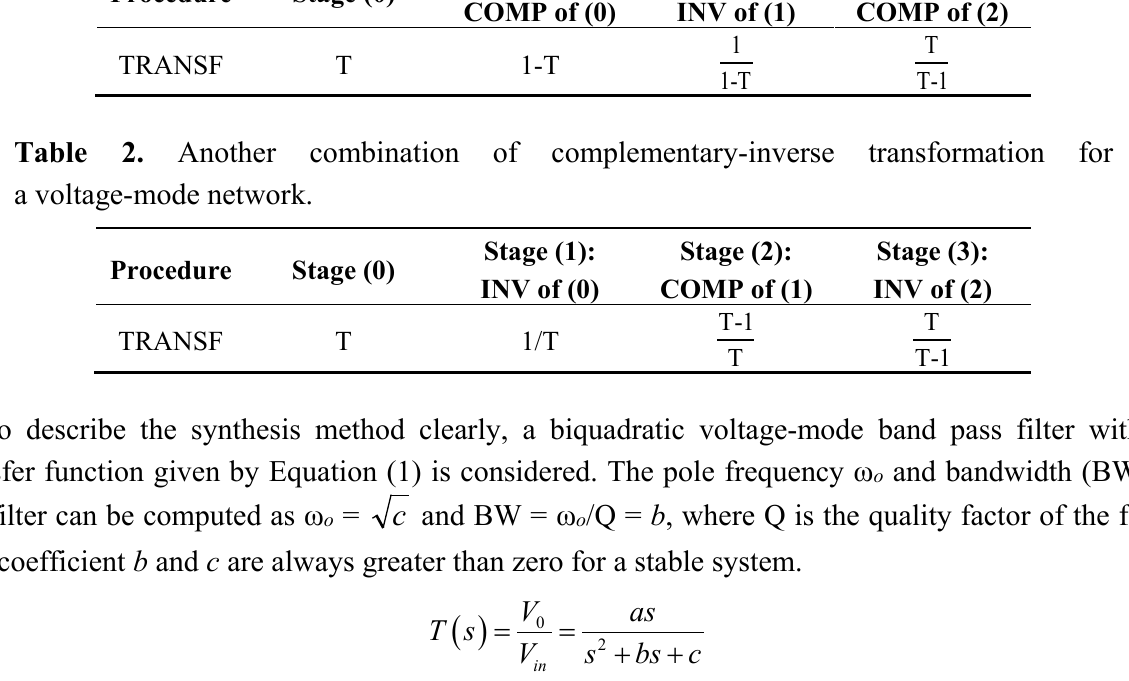
Table 1. The combination of complementary-inverse transformation (TRANSF) for a voltage-mode network. COMP, complement; INV, inverse transfer function. Procedure